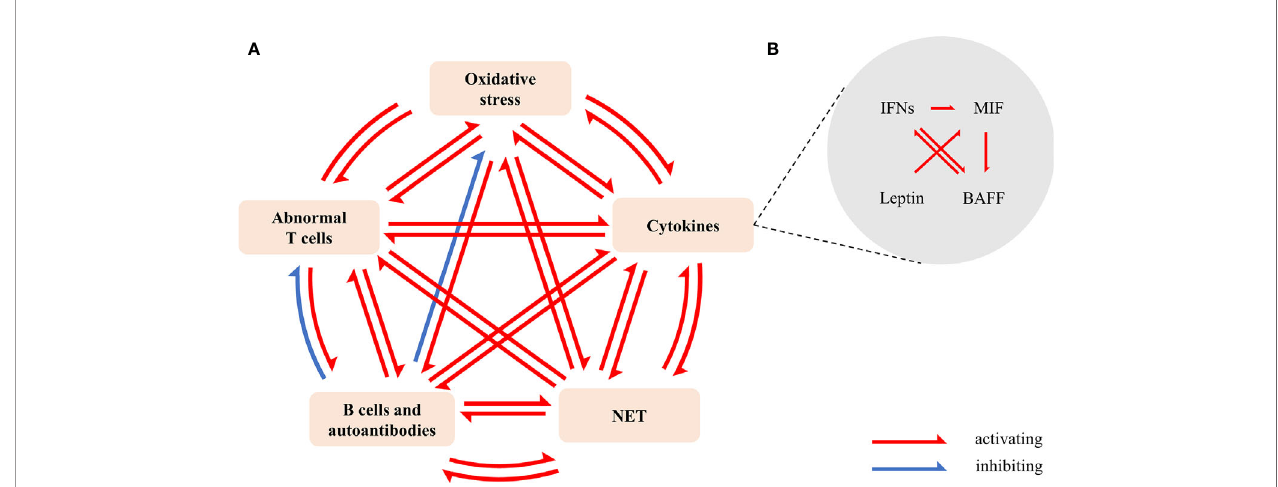
FIGURE 2 | Cross-talk between oxidative stress, cytokines, NETs, activation of B cells and autoantibodies, and abnormal T cells in SLE. (A) Oxidative stress promotes the production of IFN-I (11), NETs (12), autoantibodies (13), and the imbalance of Th17/Treg (14). IFN- a and IFN- g promote lipids oxidative modi fi cation (15, 16); BAFF promotes the production of autoantibodies (17), the release of NETs (18) and the activation of T cells (19); leptin promotes the production of autoantibodies, the release of NET and the imbalance of Th17/Treg (20, 21). NET encourages oxidation HDL (22), the expression of IFN- a (23) and IL-1 b (24), and activates NET-speci fi c memory B cells to proliferate and secrete polyclonal IgG (25). Overactive T cells increase ROS (26) and cytokines, especially IFN- g ; TFH (27, 28), CXCR5-CXCR3 + PD1hiCD4 + T helper cell (29), and peripheral helper T cell (TPH) (30) promote the differentiation of B cells and the production of antibodies. SLE- related autoantibodies and immune complexes induce the release of NET (31); anti-ApoA1-IgG guides the expression of cytokines (32). Anti-PC-IgM increases Tregs (33); anti-PC-IgM and anti-MDA-IgM reduce oxidative stress (34). (B) IFN-I (35, 36) and IFN-II (37) induce the expression and mobilization of BAFF. BAFF promotes the activation of B cells by IFN (38). Moreover, IFN-I encourages the production of MIF (39). MIF/CD74 signal regulates BAFF (40, 41). Leptin enhances MIF-induced in fl ammation (42). Besides, IFNs, MIF and leptin strengthen the expression of chemokine, adhesion molecule, TNF- a and ILs. BAFF, B cell-activating factor; MDA, malondialdehyde; MIF, macrophage migration inhibitory factor; NET, neutrophil extracellular trap; PC, choline phosphate; ROS, reactive oxygen species; TFH, follicular helper T cell; TPF, peripheral helper T